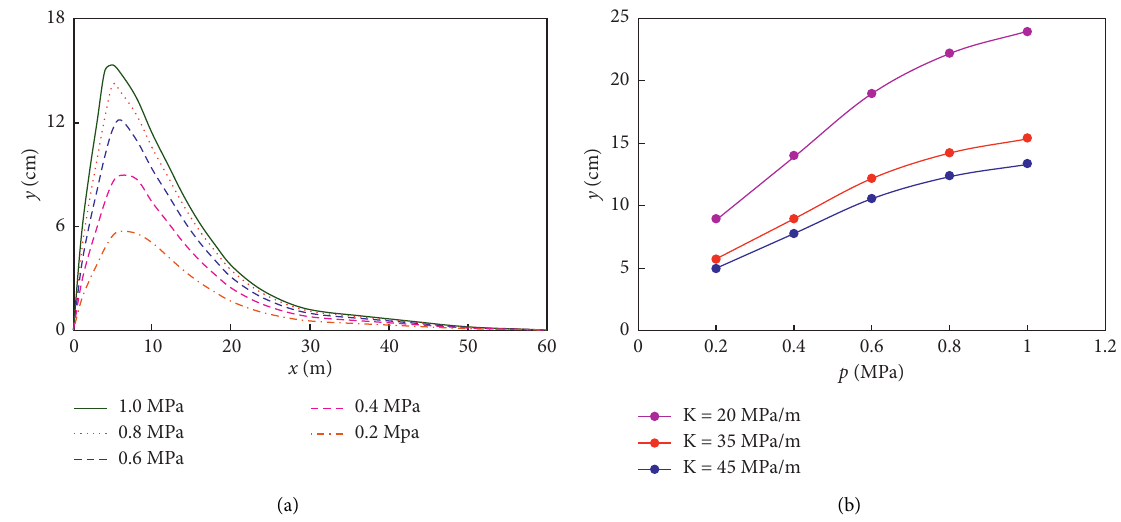
Figure 10: Influence of grout pressure on the segment uplift: (a) variation of segment uplift under different values of p ; (b) relationship between the maximum segment uplift and p